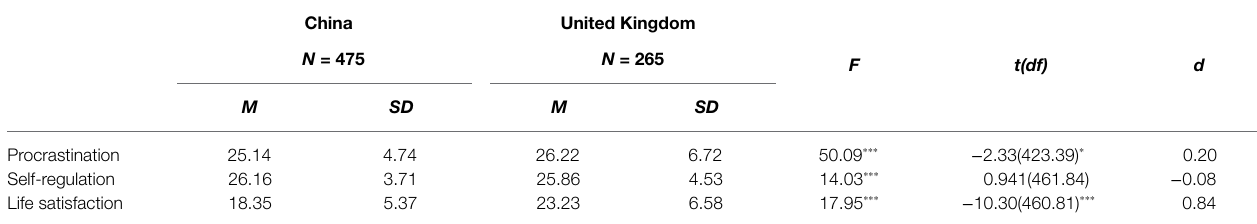
TABLE 5 | Mean differences for procrastination, self-regulation, and life